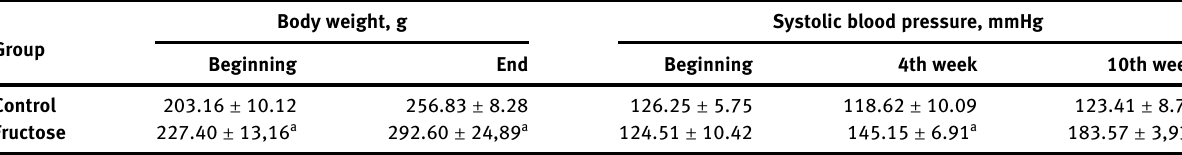
Table  : Body weights and systolic blood pressures of groups.